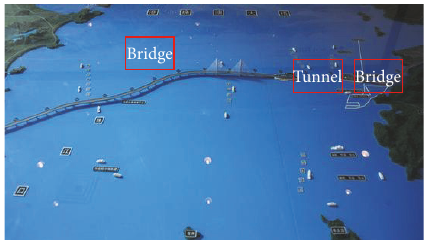
Figure 1: Hong Kong-Zhuhai-Macau linkage.